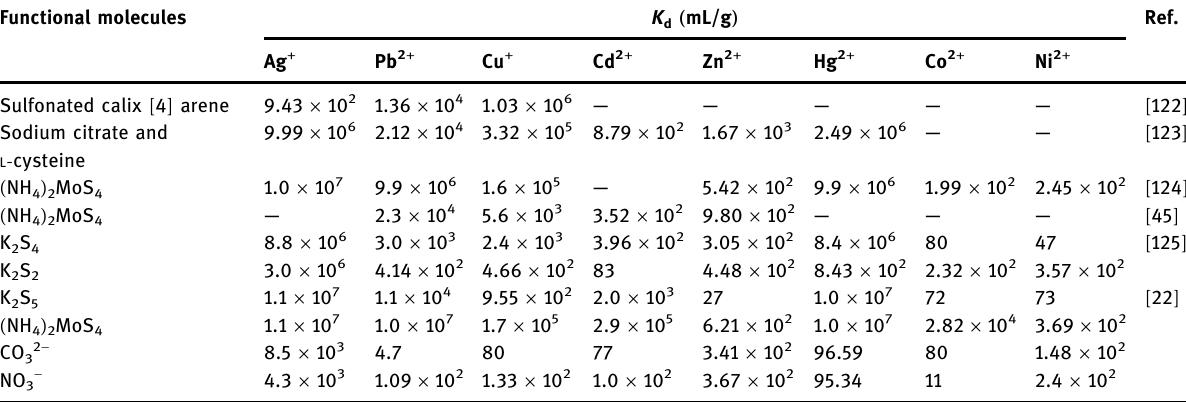
Table 5: The K d value of functionalized LDH Functional